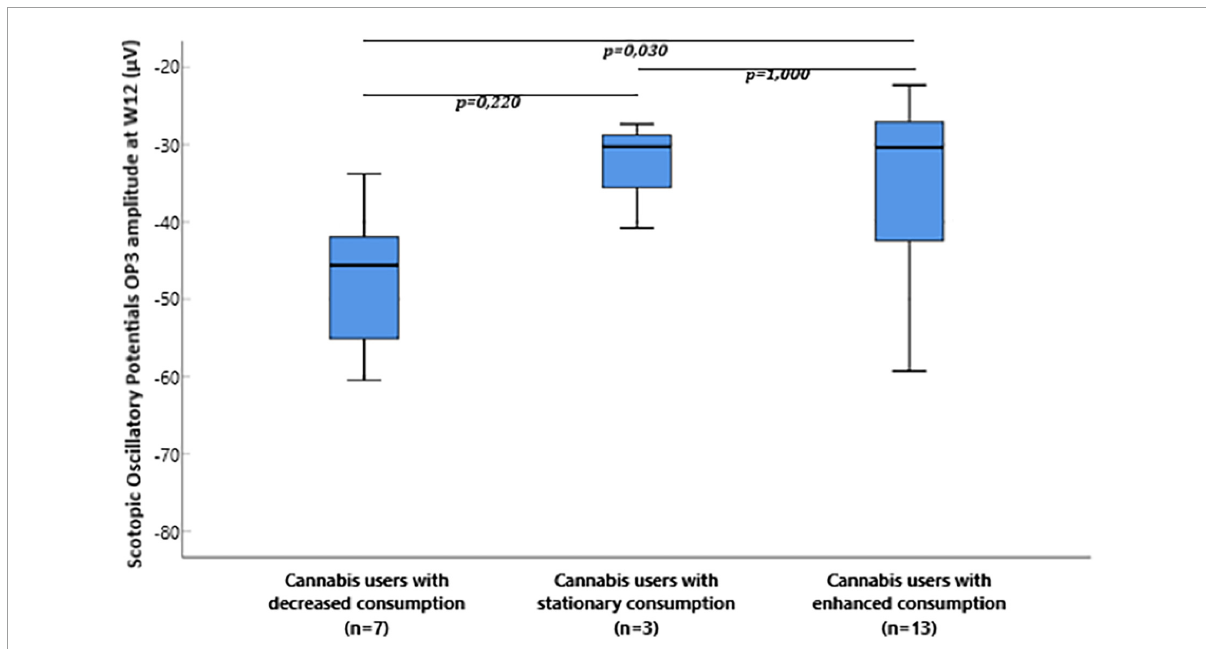
FIGURE4 Box plot of flash electroretinogram (ERG) scotopic oscillatory potentials OP3 amplitude microvolts ( µ V) at W12 in cannabis users divided in groups depending on the evolution of consumption between W8 and